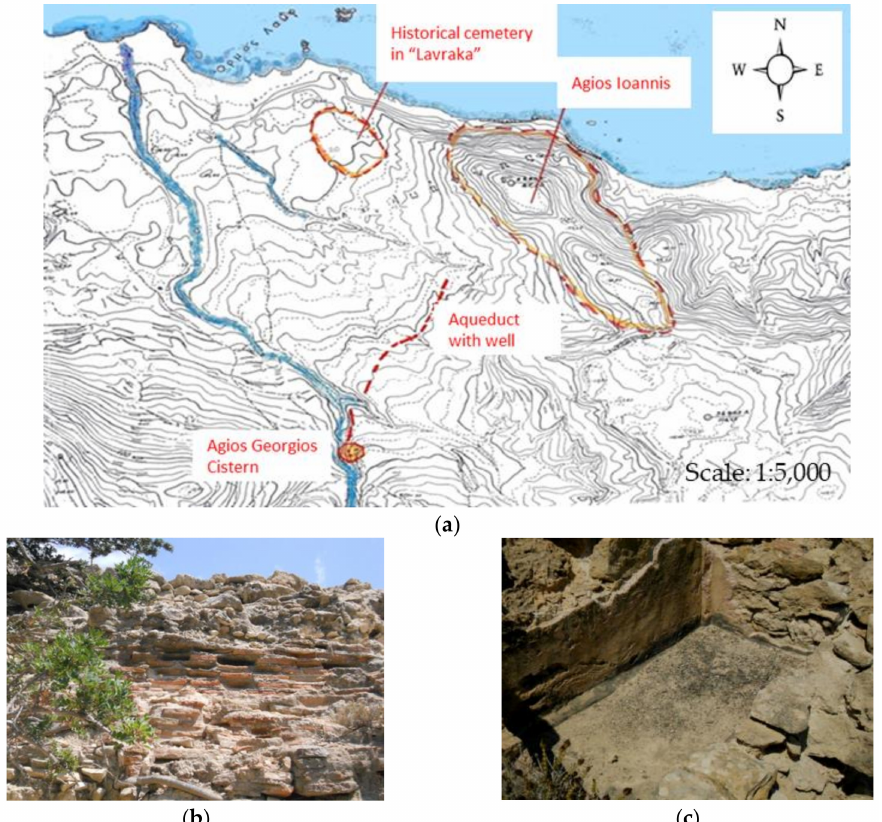
Figure 13. Roman aqueduct of the island of Gavdos: ( a ) Background scale 1:5000 (provided by Y. Christodoulakos on background of the Hellenic Military Geographical Service maps [38]), ( b ) the beginning and route of the aqueduct and ( c ) the cistern (photos taken by Y.